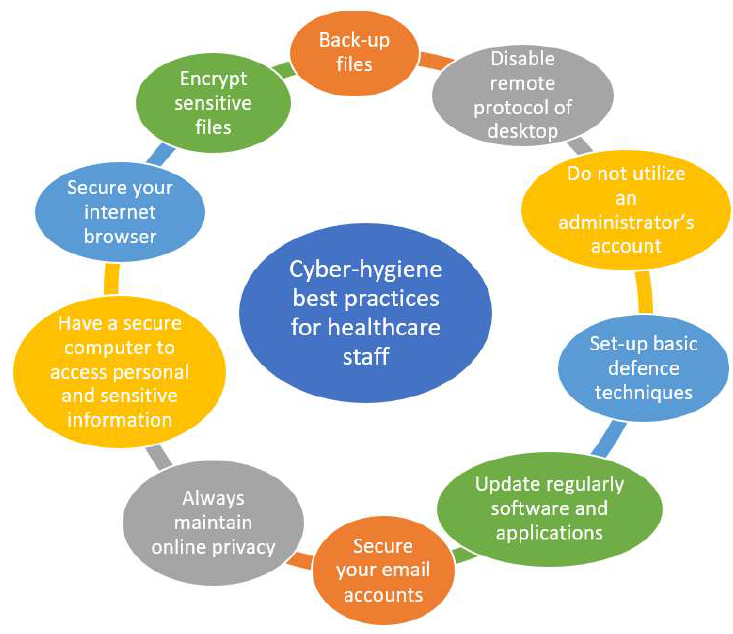
Figure 2. Cyber hygiene best practices for healthcare staff.